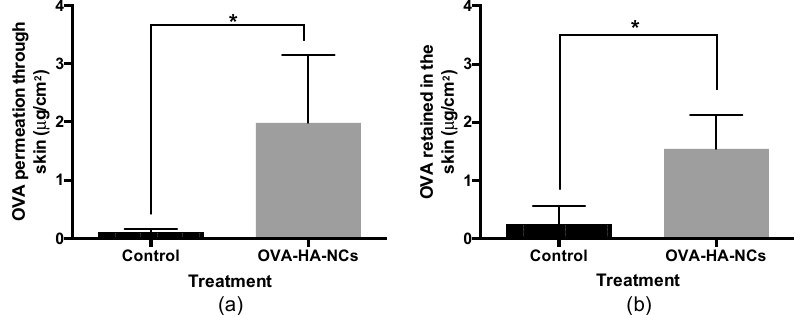
Figure 6. Effect of hyaluronic acid nanocapsules in the permeation ( a ) and retention ( b ) of ovalbumin (OVA) in pig skin. Control was OVA in solution (0.25 mg/mL). OVA-HA-NCs: OVA loaded hyaluronic acid nanocapsules. ( p < 0.05).